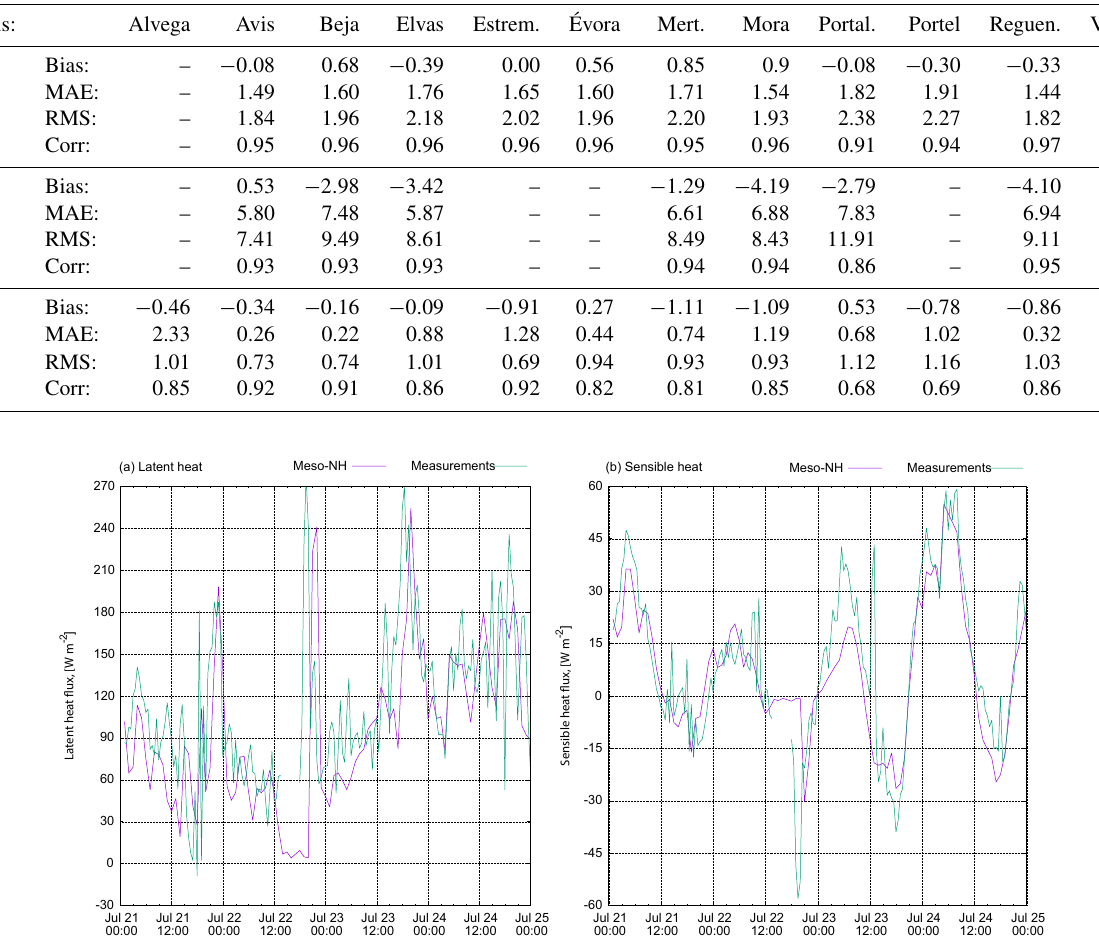
Table 2. Statistics for the hourly values of the station validation.